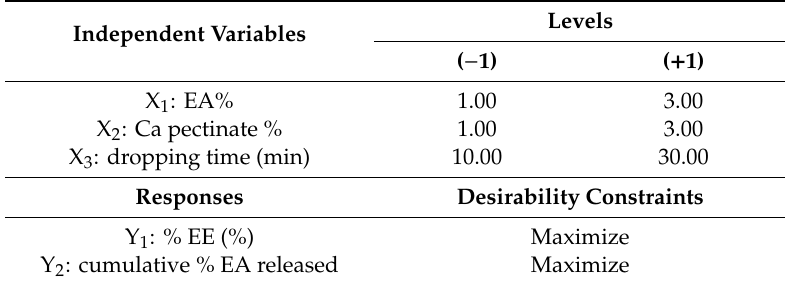
Table 1. Independent variables and responses used in the 2 3 full factorial experimental design for the formulation and optimization of EA–Ca pectinate beads.